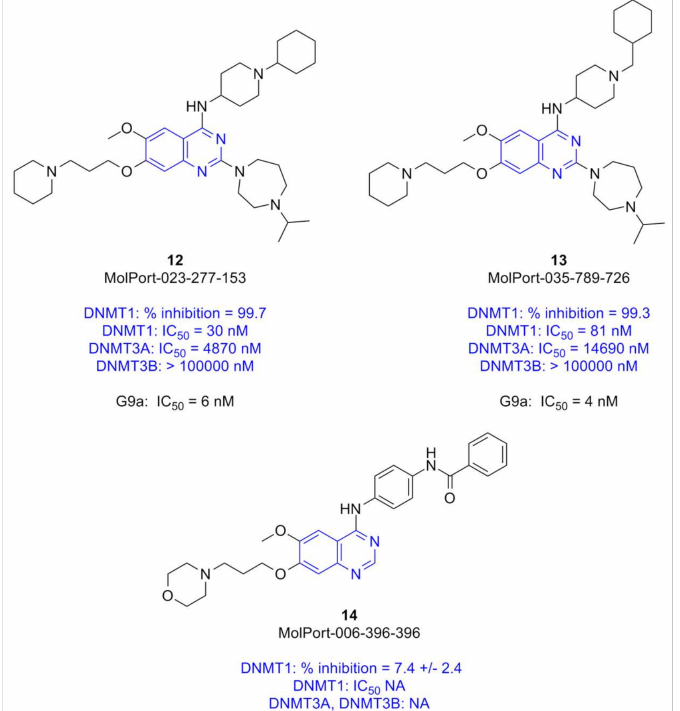
Figure 2. Chemical structures of quinazoline-based derivatives tested in enzymatic inhibition assays. The enzymatic DNMT inhibitory activity measured in this work is included in blue font. Mean value of two measurements. SAH was included as a positive control: IC 50 (DNMT1) of 0.34 µ M; IC 50 (DNMT3A) of 0.10 µ M; (DNMT3B) of 0.03 µ M. For reference, the enzymatic G9a inhibitory activity of 12 and 13